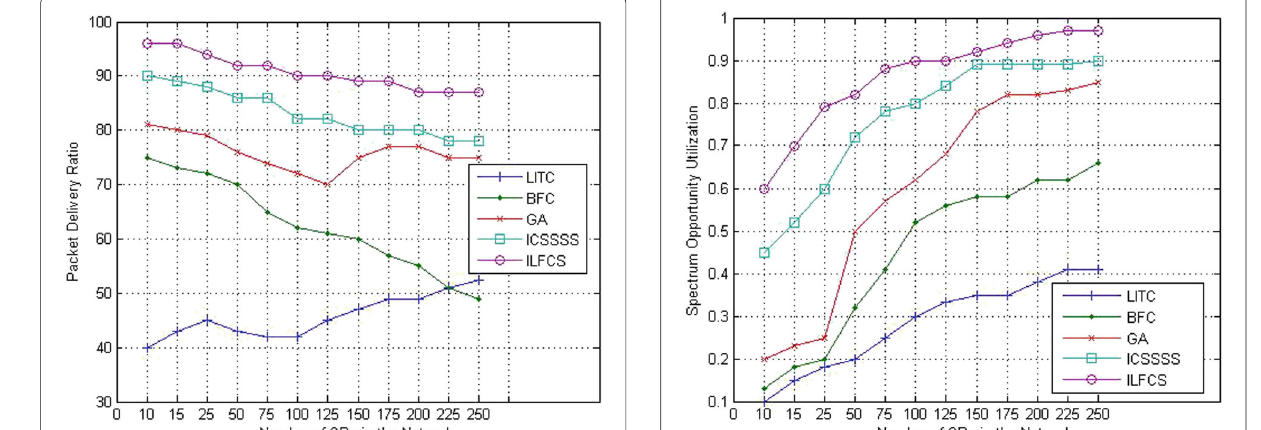
total packets received in the network and the ratio of inter- ference. When the number of CRs successfully completed its transmission, this leads to the increase of the total number of successfully received packets. Consequently, the average throughput increases.